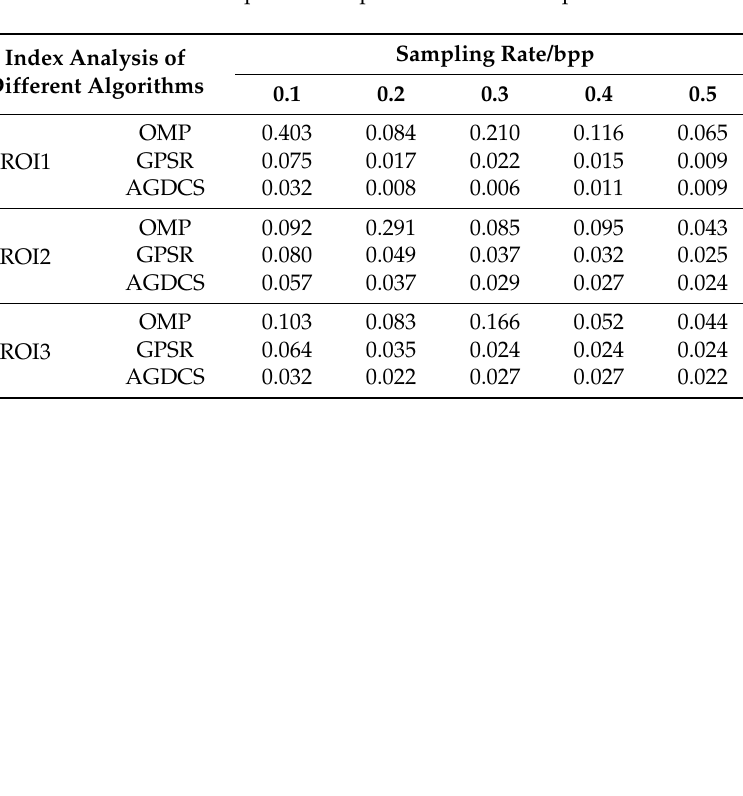
Table 5. RMSE comparison of spectral indices of